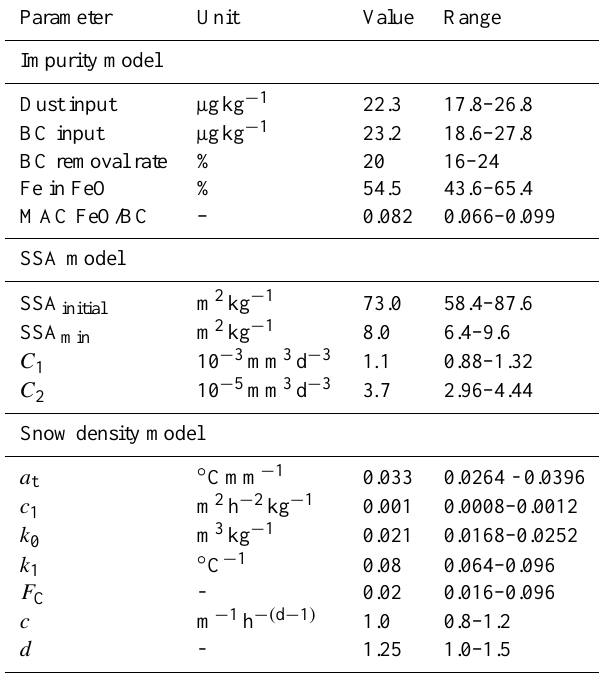
Table 1. Parameters of the impurity, the SSA and the snow density model and the corresponding parameter ranges ( ± 20%) applied in the sensitivity